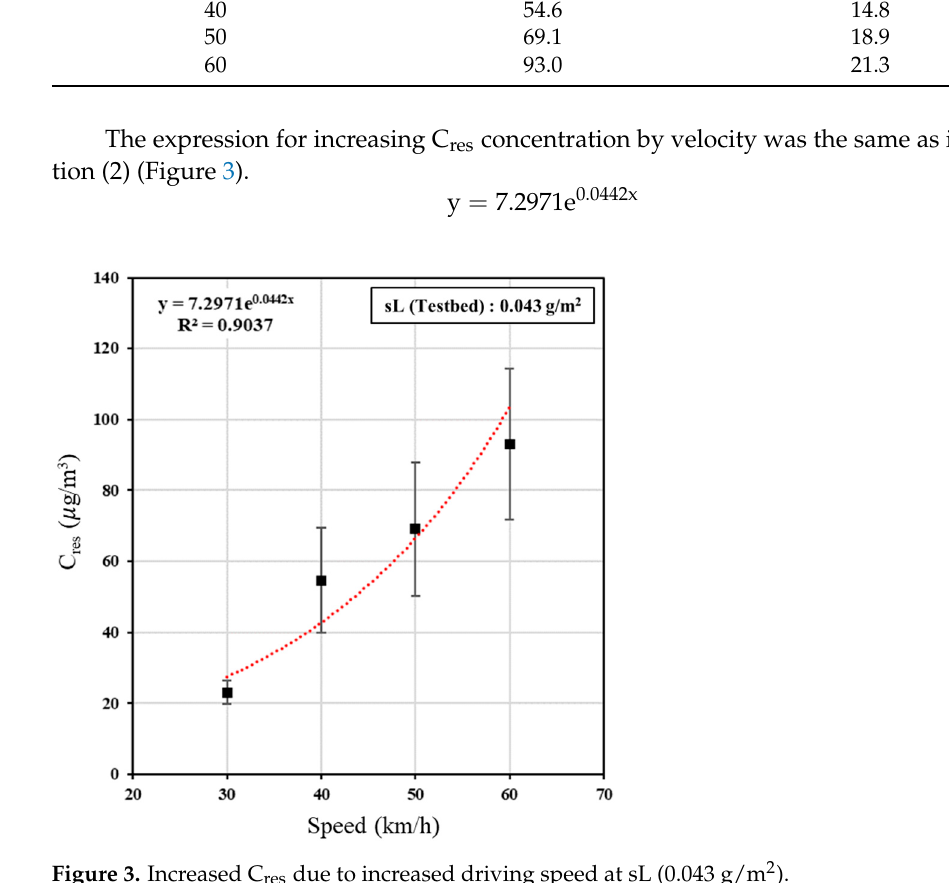
Figure 3. Increased C res due to increased driving speed at sL (0.043 g/m 2 ).